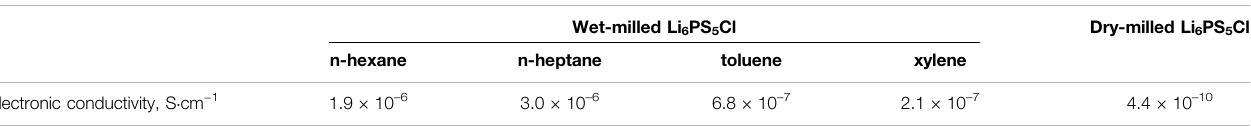
TABLE 2 | Ionic conductivities Li 6 PS 5 Cl electrolyte pellet